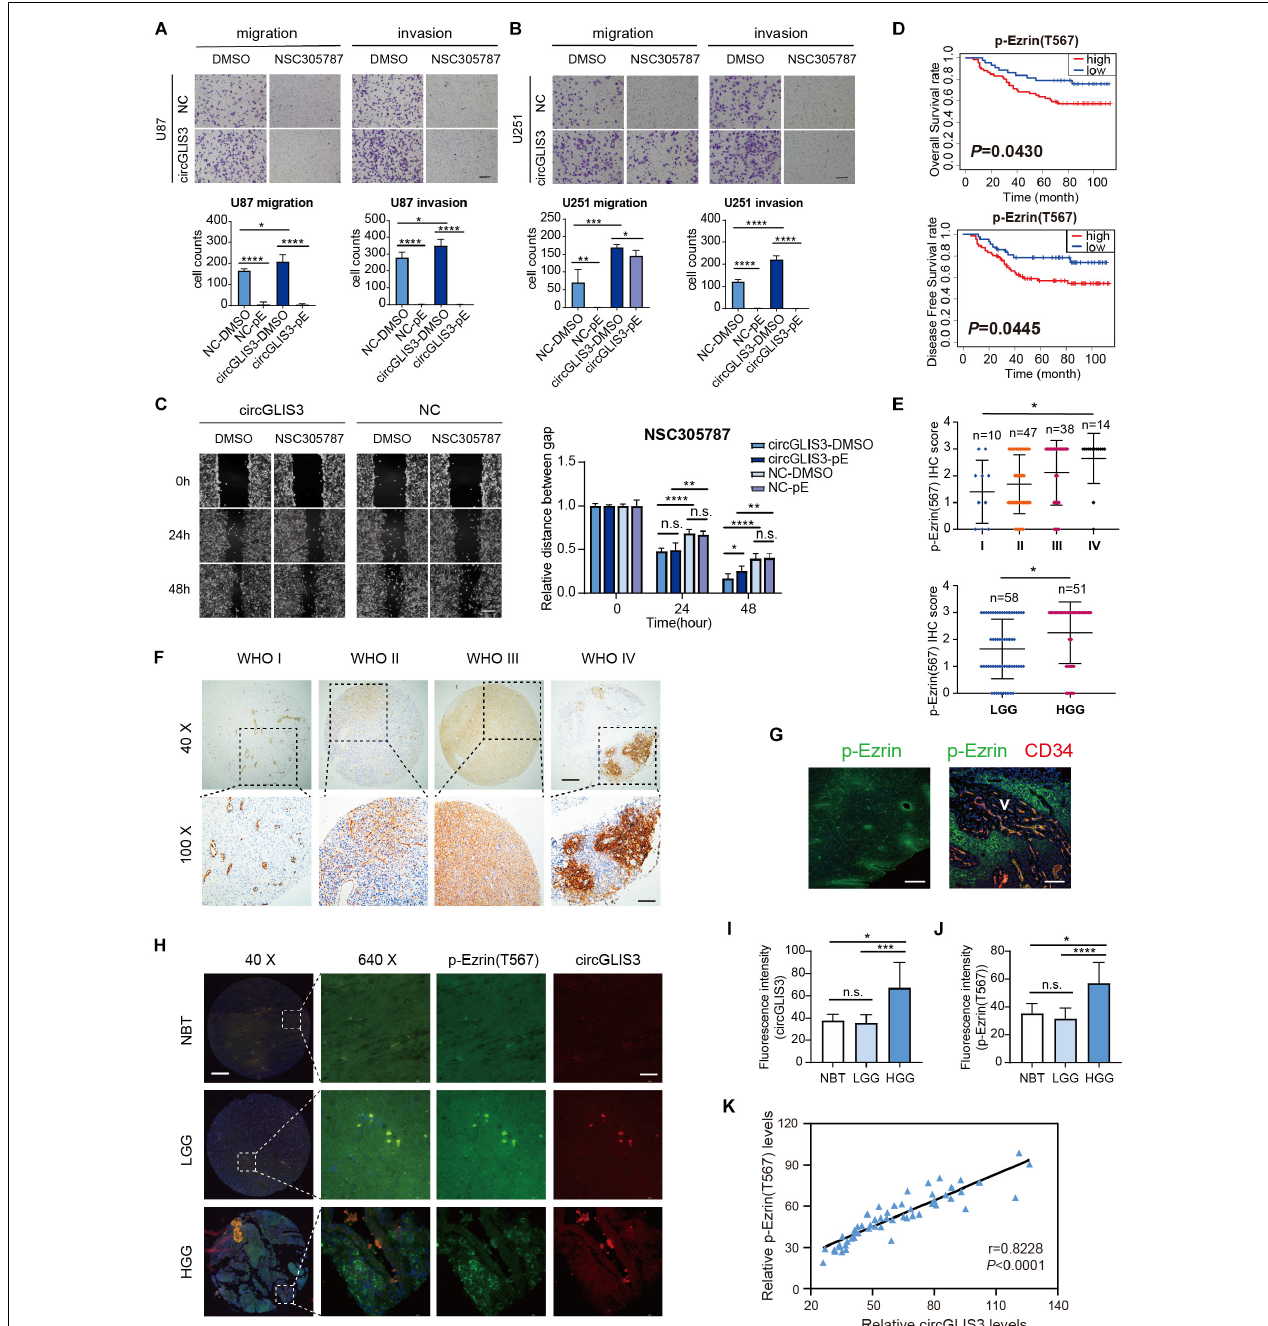
FIGURE 4 | Elevated p-Ezrin(T567) is related to high grade and poor prognosis of glioma patients. (A) Transwell migration and invasion of U87 and (B) U251 cells, 3 × 10 4 cells were seeded and treated with 1 µ M NSC305787 (noted as pE group) or DMSO for 24 h (magnification, × 100, scale bar, 100 µ m). (C) Wound healing assay of U251 cells after being transfected with plasmid for 2 days and treated with 0.5 µ M NSC305787 (noted as pE group) or DMSO (magnification, × 100; scale bar, 100 µ m). (D) Kaplan–Meier survival curve analysis and (E) dot distribution graph of p-Ezrin(T567) IHC staining score were shown within 109 glioma patients of different WHO grades. (F) IHC staining of p-Ezrin(T567) in 109 different grades of gliomas. Vascular endothelial cells also showed a strong positive stain with p-Ezrin(T567) (magnification, × 40 (upper), scale bar, 200 µ m; × 100 (lower), scale bar, 100 µ m). (G) Immunofluorescence stain of p-Ezrin(T567) and CD34 in glioma tissue (scale bar, left: 300 µ m, right: 80 µ m). (H) Fluorescence in situ hybridization of circGLIS3 and immunofluorescence stain of p-Ezrin(T567) in 58 NBT and glioma samples (NBT = 3, LGG = 9, HGG = 46) [magnification, × 40 (left), scale bar, 200 µ m; × 640 (right), scale bar, 40 µ m]. (I) Fluorescence intensity analysis of circGLIS3 in situ stain in 58 samples. (J) Fluorescence intensity analysis of p-Ezrin(T567) in situ stain in 58 samples. (K) A positive correlation was shown between circGLIS3 and p-Ezrin(T567) expression in 58 samples using Pearson correlation analysis. The results are presented as the mean ± SEM. * P < 0.05, ** P < 0.01, *** P < 0.001, **** P <